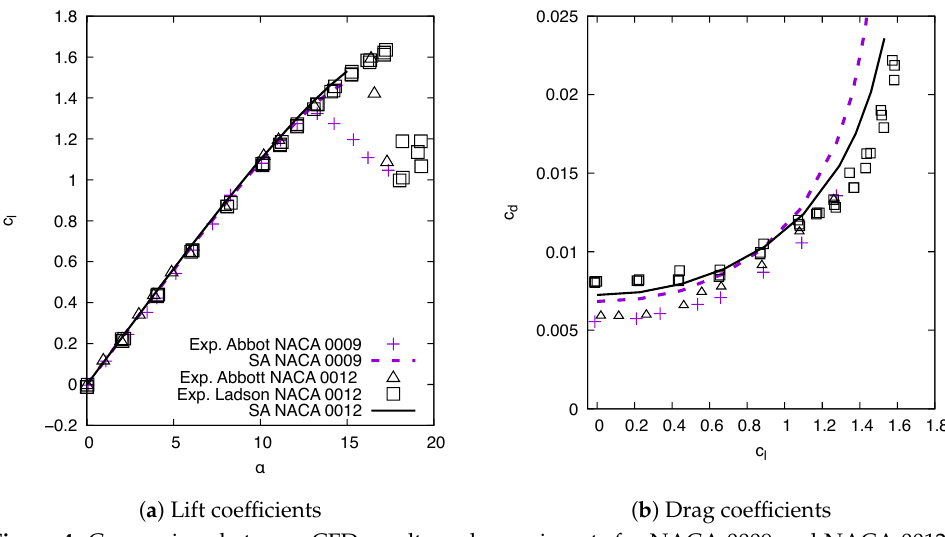
Figure 4. Comparison between CFD results and experiments for NACA 0009 and NACA 0012 at Re = 6 × 10 6 . Legend applies to ( a , b ). Ladson results are obtained by tripping the boundary layer at the airfoil leading edge. Abbot results are not